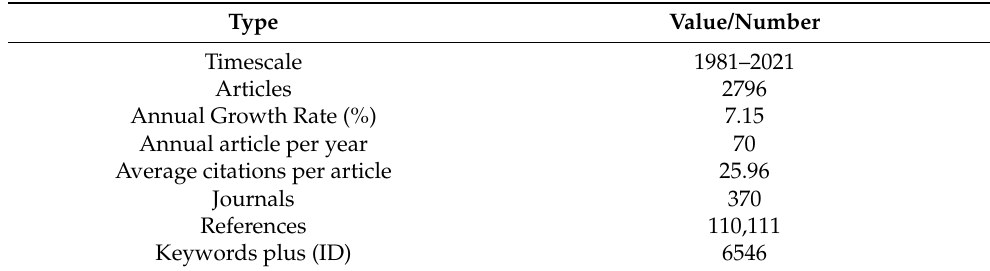
Table 1. Basic results are derived from the search strategy in the Web of Science